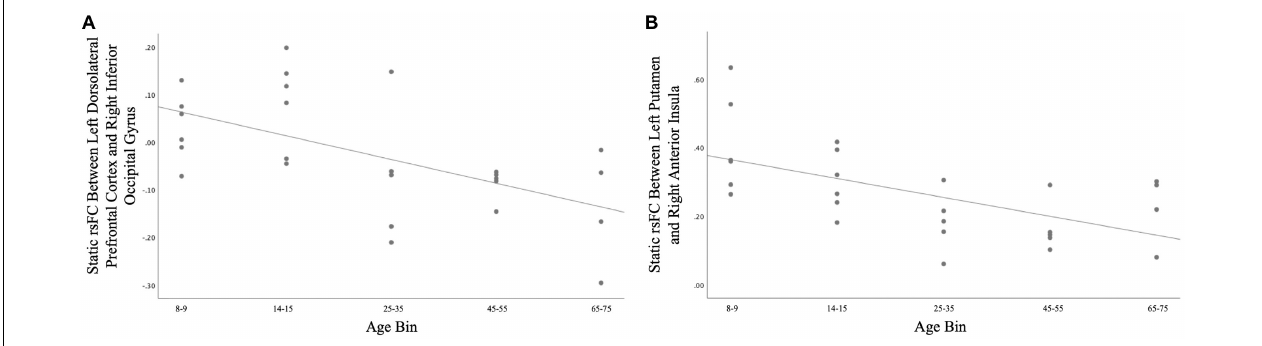
FIGURE 3 | (A) Age differences in static rsFC between right inferior occipital gyrus and left dorsolateral prefrontal cortex [ t (21) = − 4.01, p = 0.00063]. Of note, similar patterns were observed for the effect of age on static rsFC between other ROIs in visual systems and ROIs in other canonical networks. (B) Age differences in static rsFC between left putamen and right anterior insula [ t (21) = − 3.92, p = 0.00075]. Similar age effects were detected between other ROIs in the canonical affective network and ROIs in the canonical salience